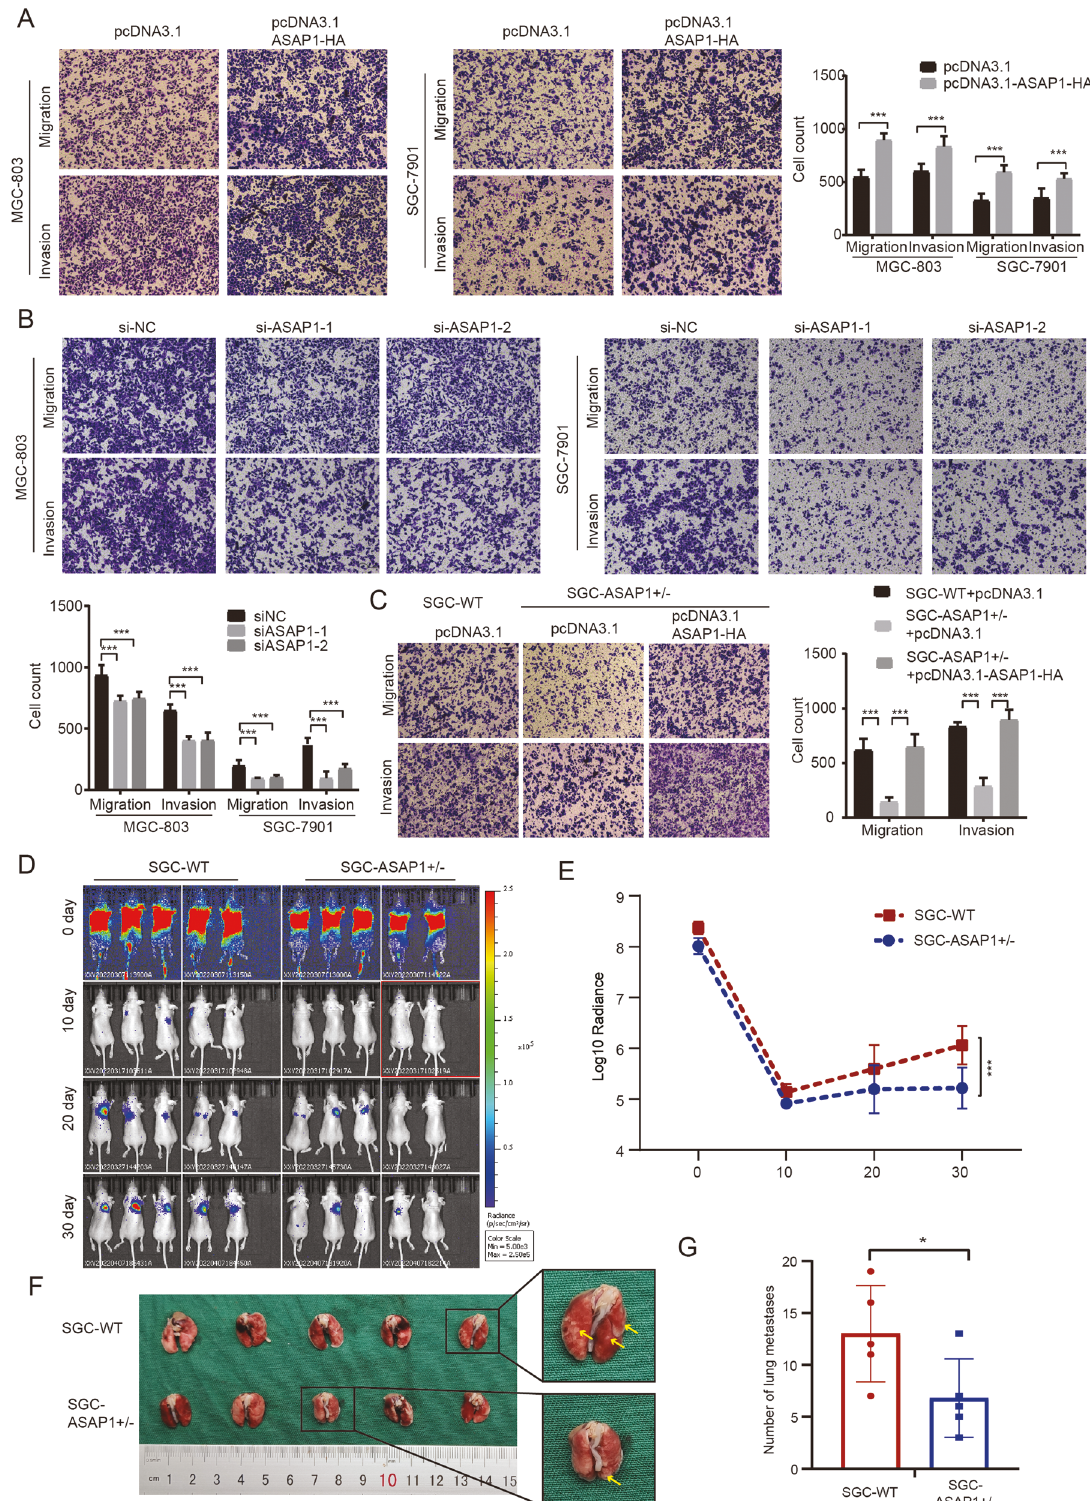
Fig. 4 ASAP1 promote GC cell migration and invasion in vitro and in vivo. A , B , C Representative images from transwell assays with MGC- 803 and SGC-7901 cells expressing ASAP1-HA, depleted of ASAP1 or partially knocked out of ASAP1. The numbers of migrating and invading cells are presented in the right panel. Scale bar,100 μ m. D , E SGC-7901-WT-Luc and ASAP1 + / − SGC-7901-Luc were injected into tail veins of nude mice to construct lung metastasis models, respectively, 30 days after injection, metastasis of GC cells in lungs of nude mice was evaluated and quanti fi ed. F , G Specimen graphs of lung metastases and statistical graphs of the number of tumors metastasizing in the lungs ns-not signi fi cant; * P < 0.05, ** P < 0.01, and *** P < 0.001.